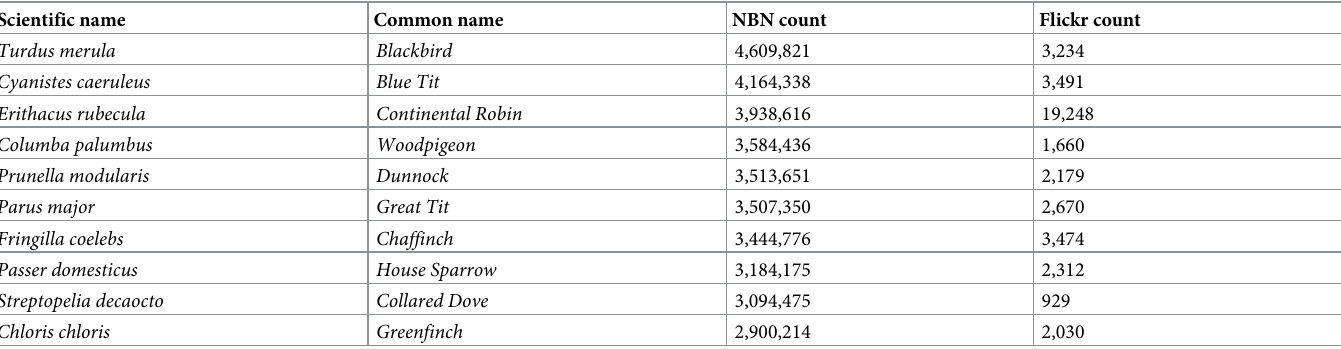
Table 3. The top 10 species on NBN with the highest number of records.